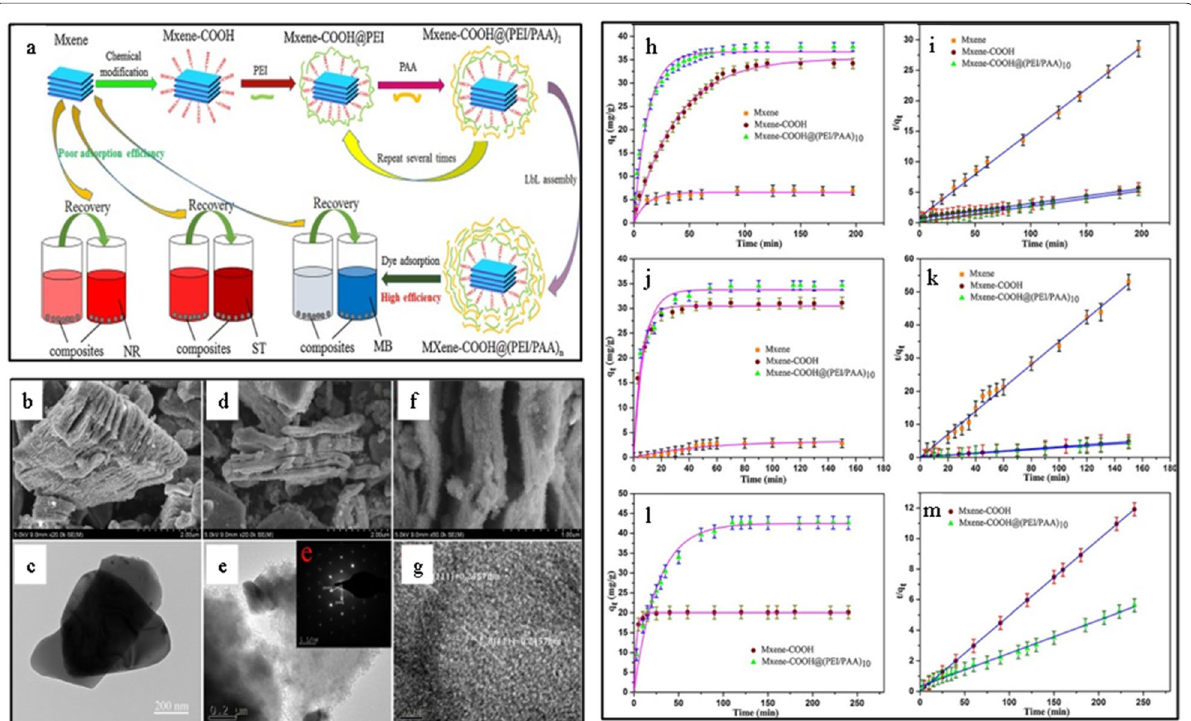
Fig. 2 a Schematic illustration of the fabrication of the MXene-COOH@(PEI/PAA) n composite. b – g SEM and TEM images of MXene, MXene-COOH, and the composite. h – m Adsorption capacities and rate constants for MXene, MXene-COOH, and the composite for MB, ST, and NR dyes at 298 K respectively. Reprint with permission[21]: copyright 2018, Elsevier